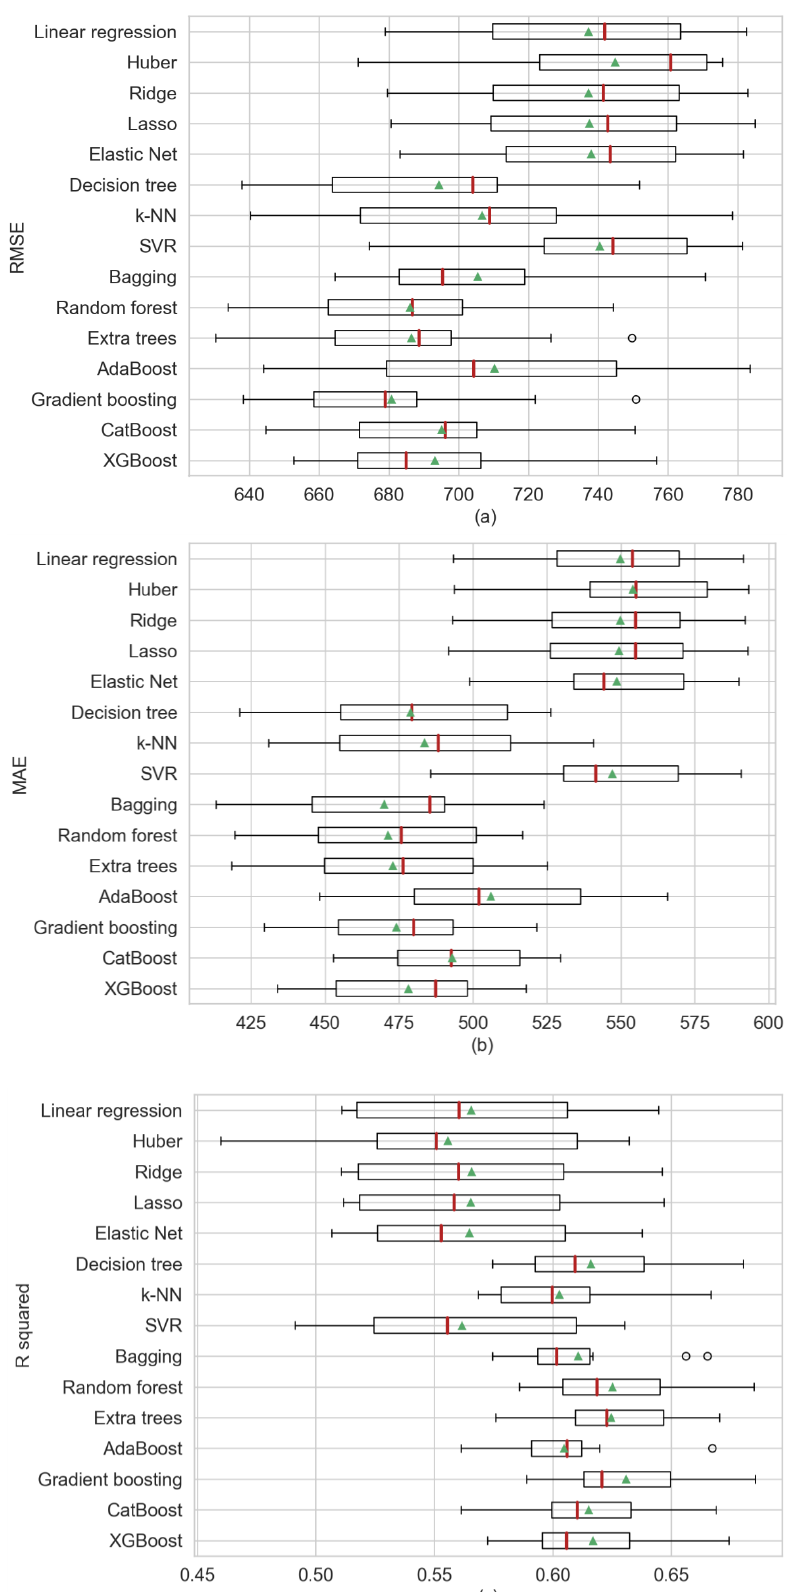
The best values are in underlined boldface.